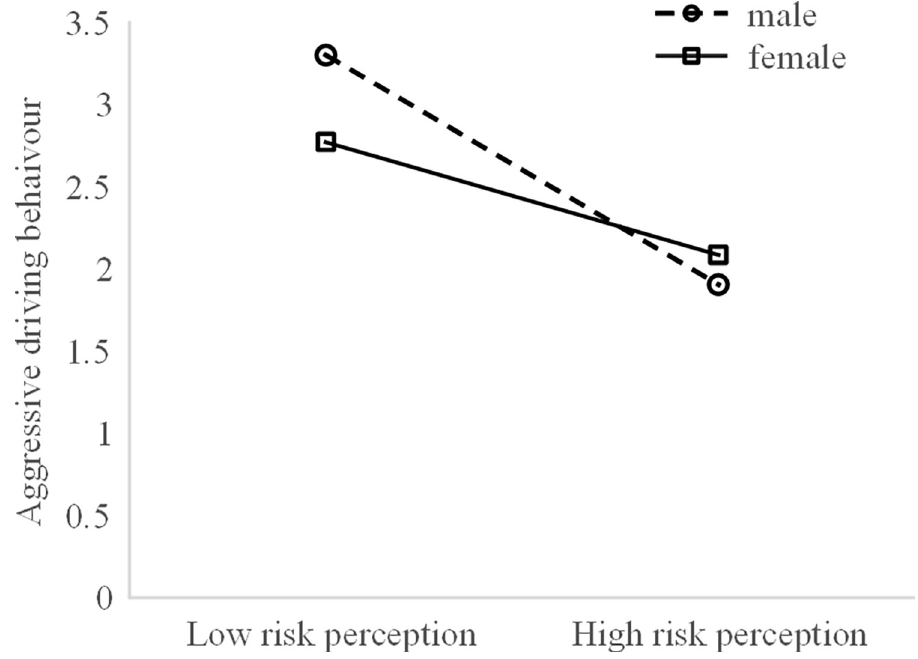
Fig 6. Simple slope analysis of aggressive behaviours-gender × risk perception.